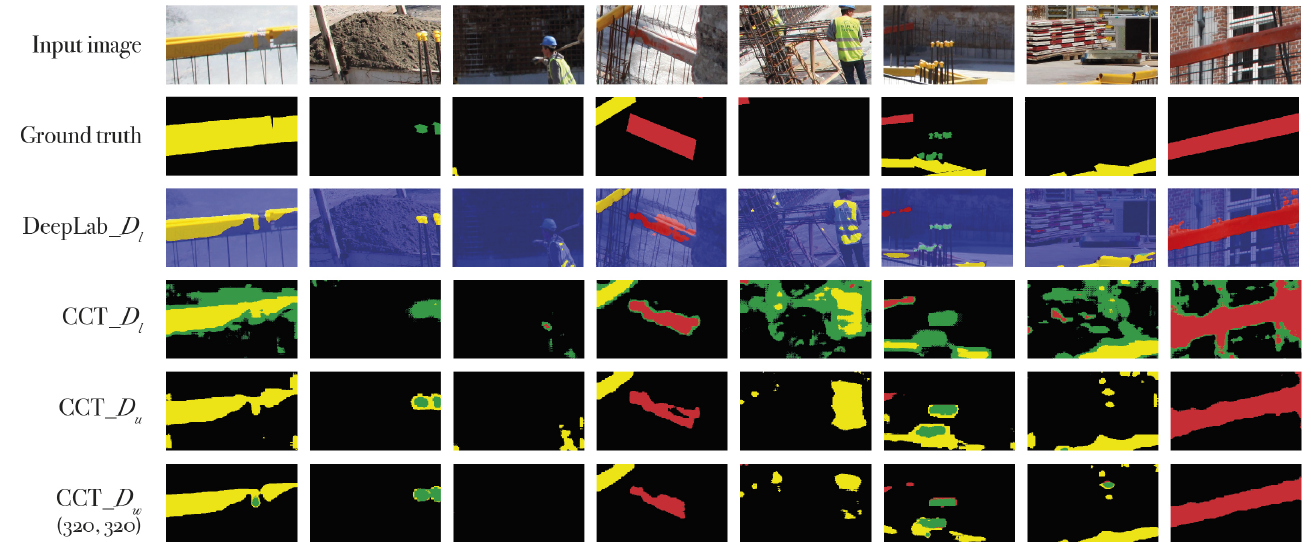
Figure 9. Qualitative results of the trained CCT models and DeepLabv3+ on the D u / D w